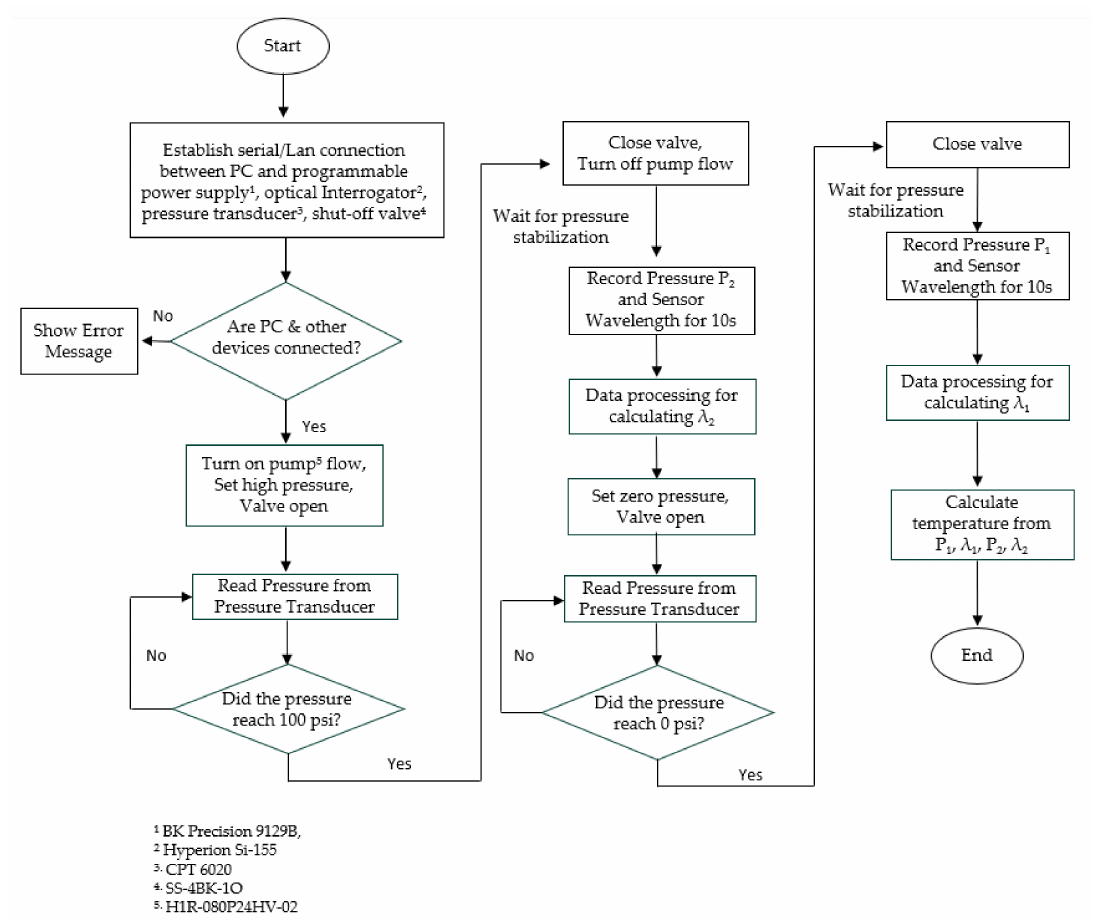
Figure 3. Flowchart of the temperature measurement system